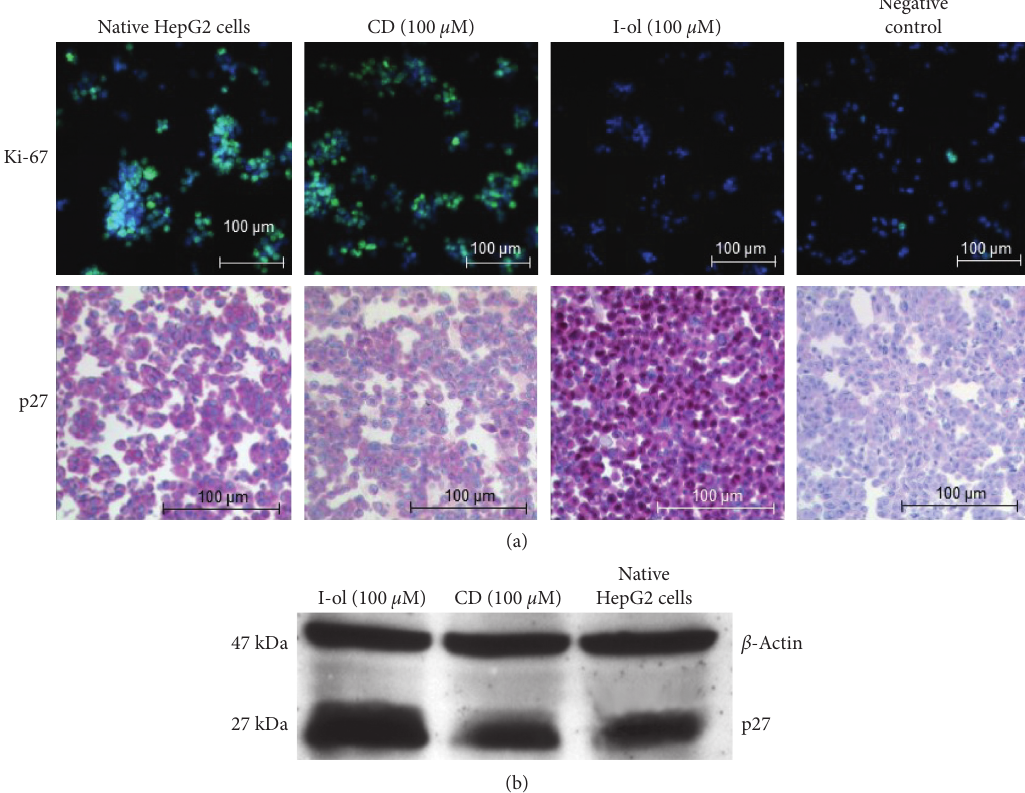
Figure 4: Expression of cellular Ki-67 and p27 in cultured HepG2 cells. (a) Immunofluorescent staining of Ki-67 and immunohistochemical staining of p27 in HepG2 cells. The magnification of the objective lens was 20-fold and that of the ocular lens was 10-fold, so the total magnification was 200-fold. Ki-67 protein expression was almost undetectable in cells treated with 100 μ M I-ol. In contrast, p27 expression increased by many times compared to both control groups. (b) Western blot analysis of p27 expression in protein extracts. The marked increase in p27 protein expression caused by I-ol treatment correlated very well with the previous results obtained with cultured cells. Representative images are